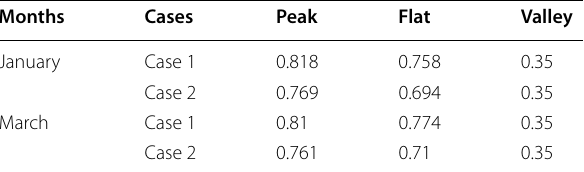
Table 1 Optimal TOU electricity of different cases Months